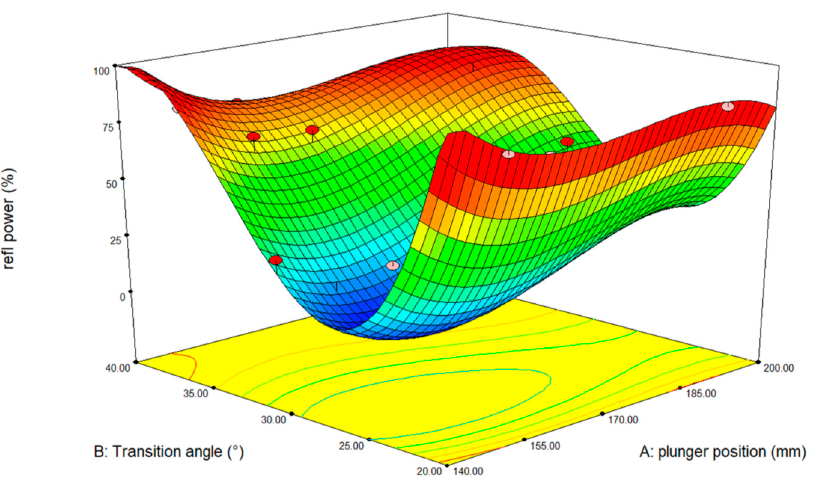
Figure 4. Reflected power (|S11| 2 ) as a function of the design parameters: plunger position and cone angle.